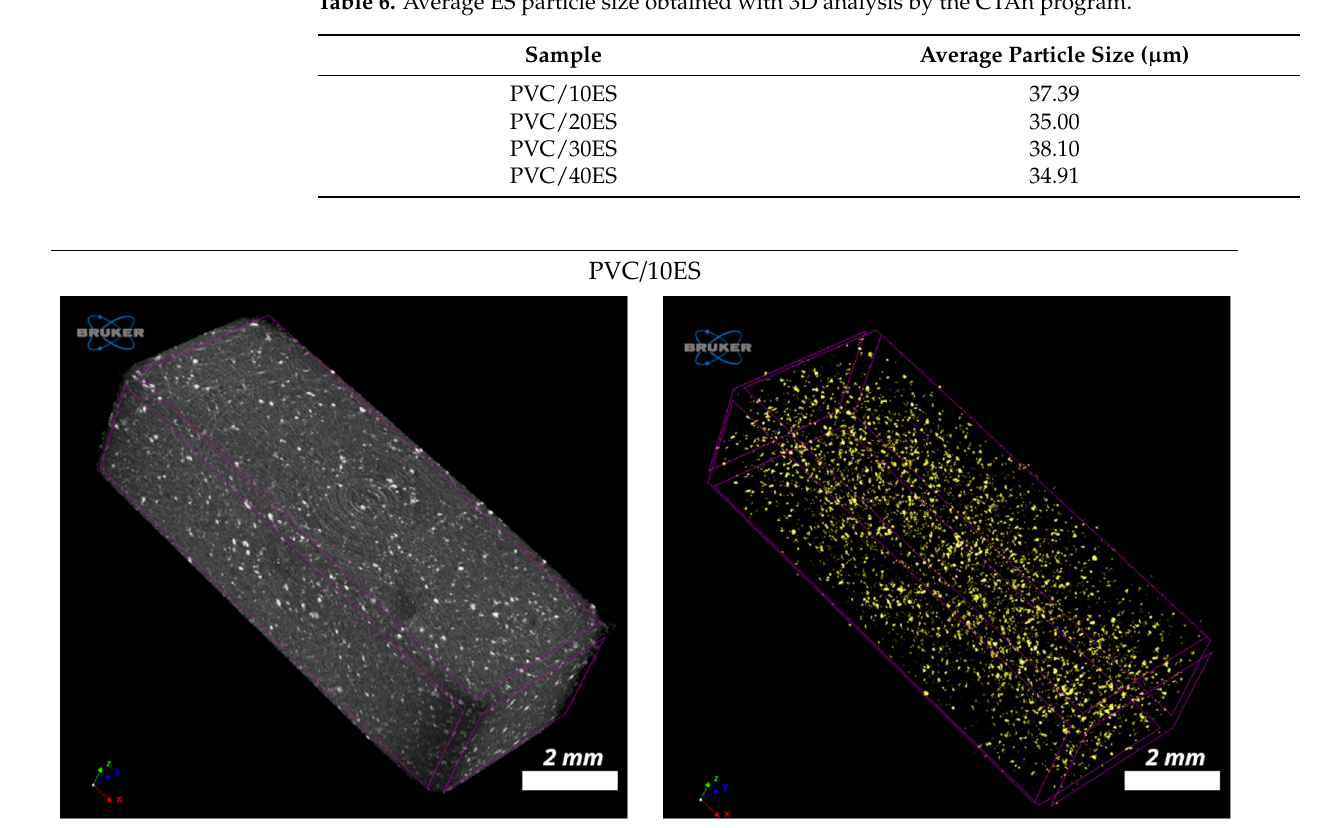
Table 6. Average ES particle size obtained with 3D analysis by the CTAn program.